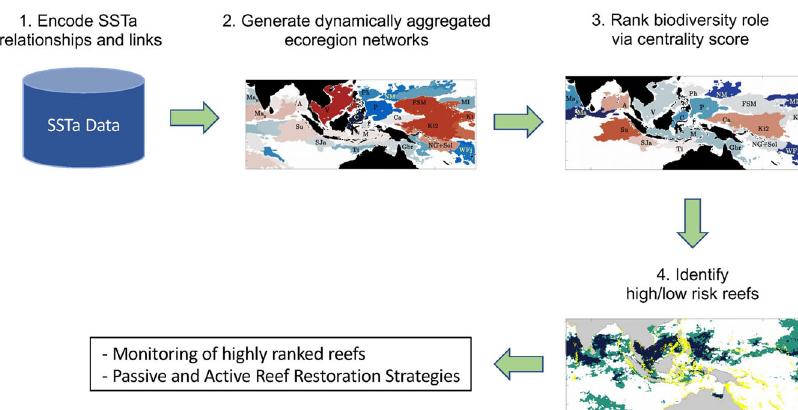
Fig. 2 Conceptual framework and work fl ow. Schematic representation of the proposed ecoregionalization, connectivity and resilience framework.